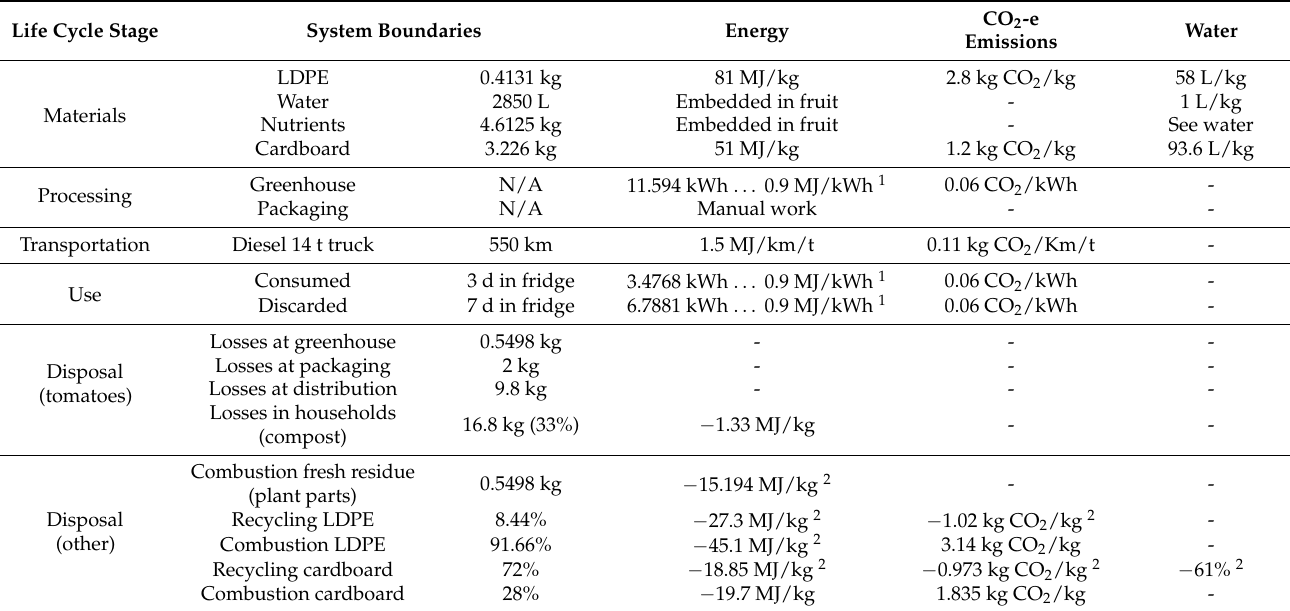
Table 1. Baseline data for the environmental impact calculations for the life cycle stages of the greenhouse tomato, per 100 kg of